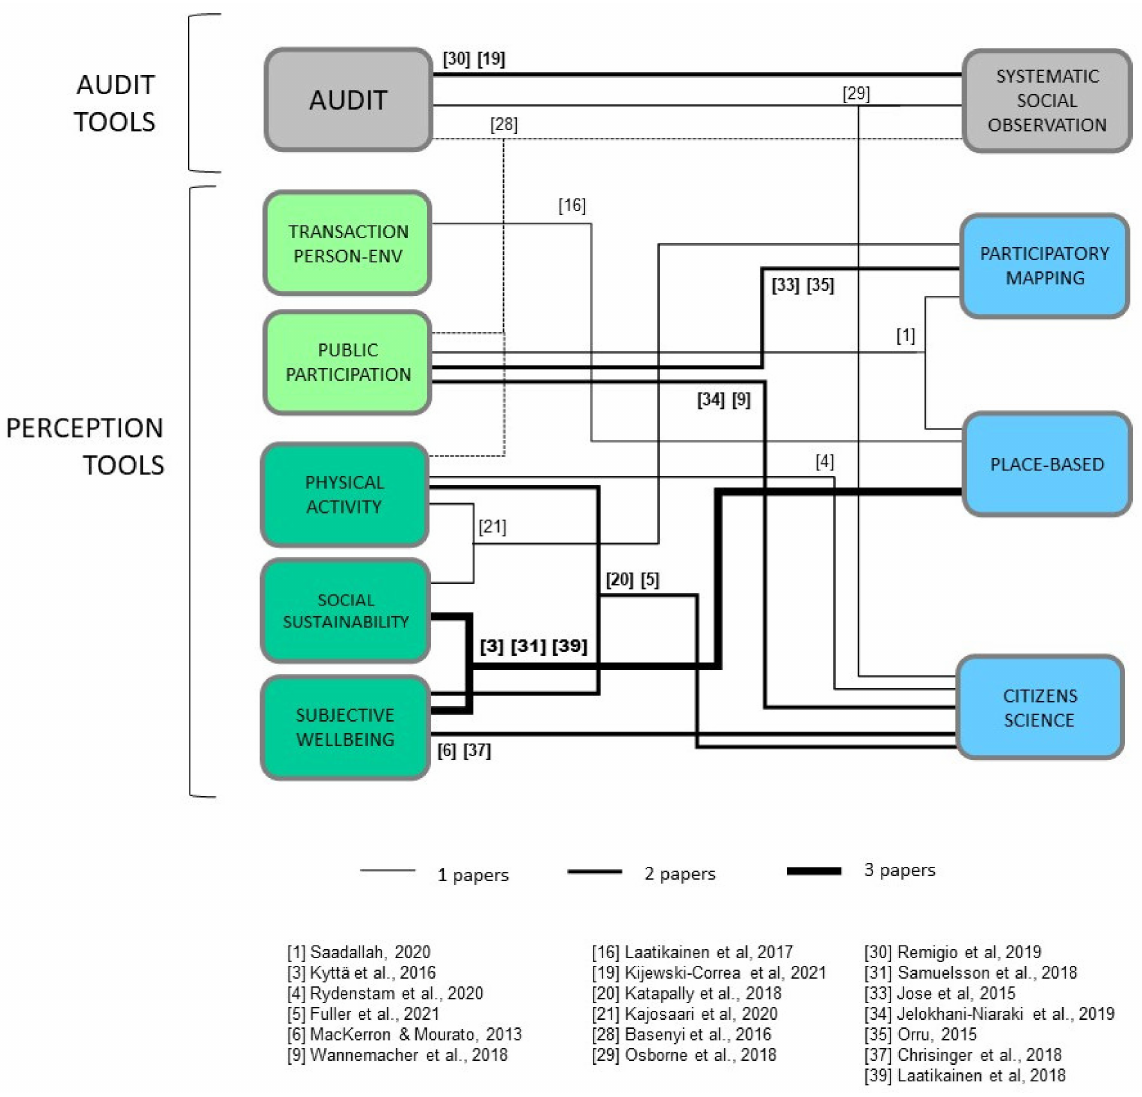
Figure 7. Summary diagram relating theoretical with methodological